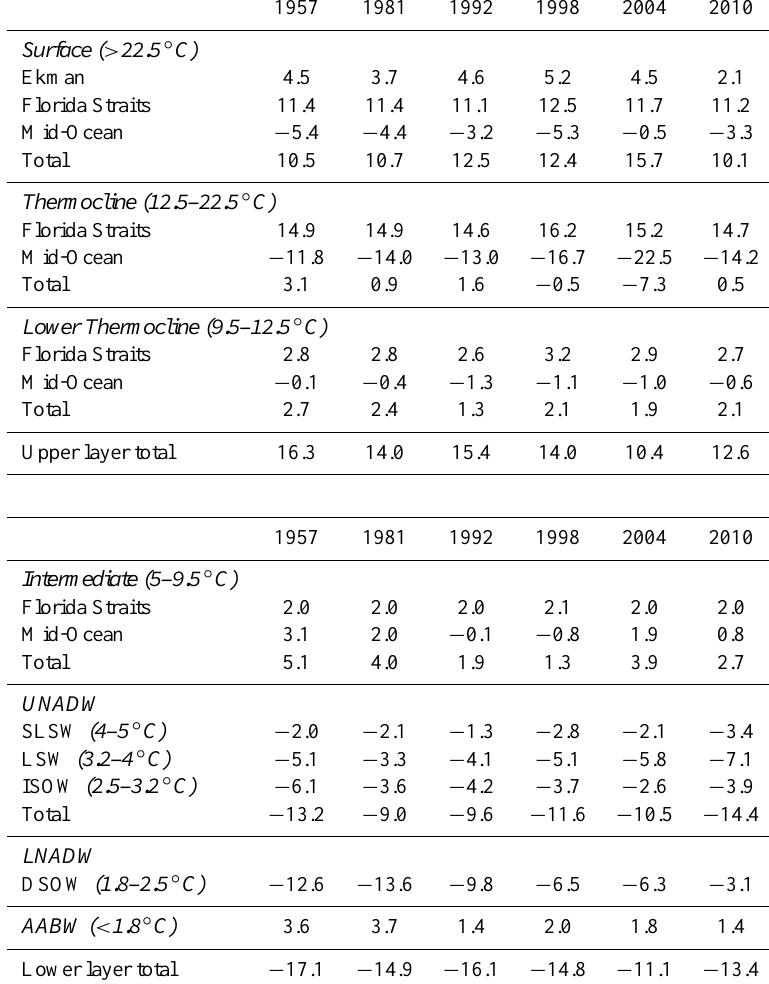
Table 6. Northward transport (Sv) in potential temperature classes for the six hydrographic sections; for full class definitions see Table 3. Layer totals are also given. Note that net imbalance between upper and lower layer total transports is due to Bering Straits inflow (0.8Sv) to the North